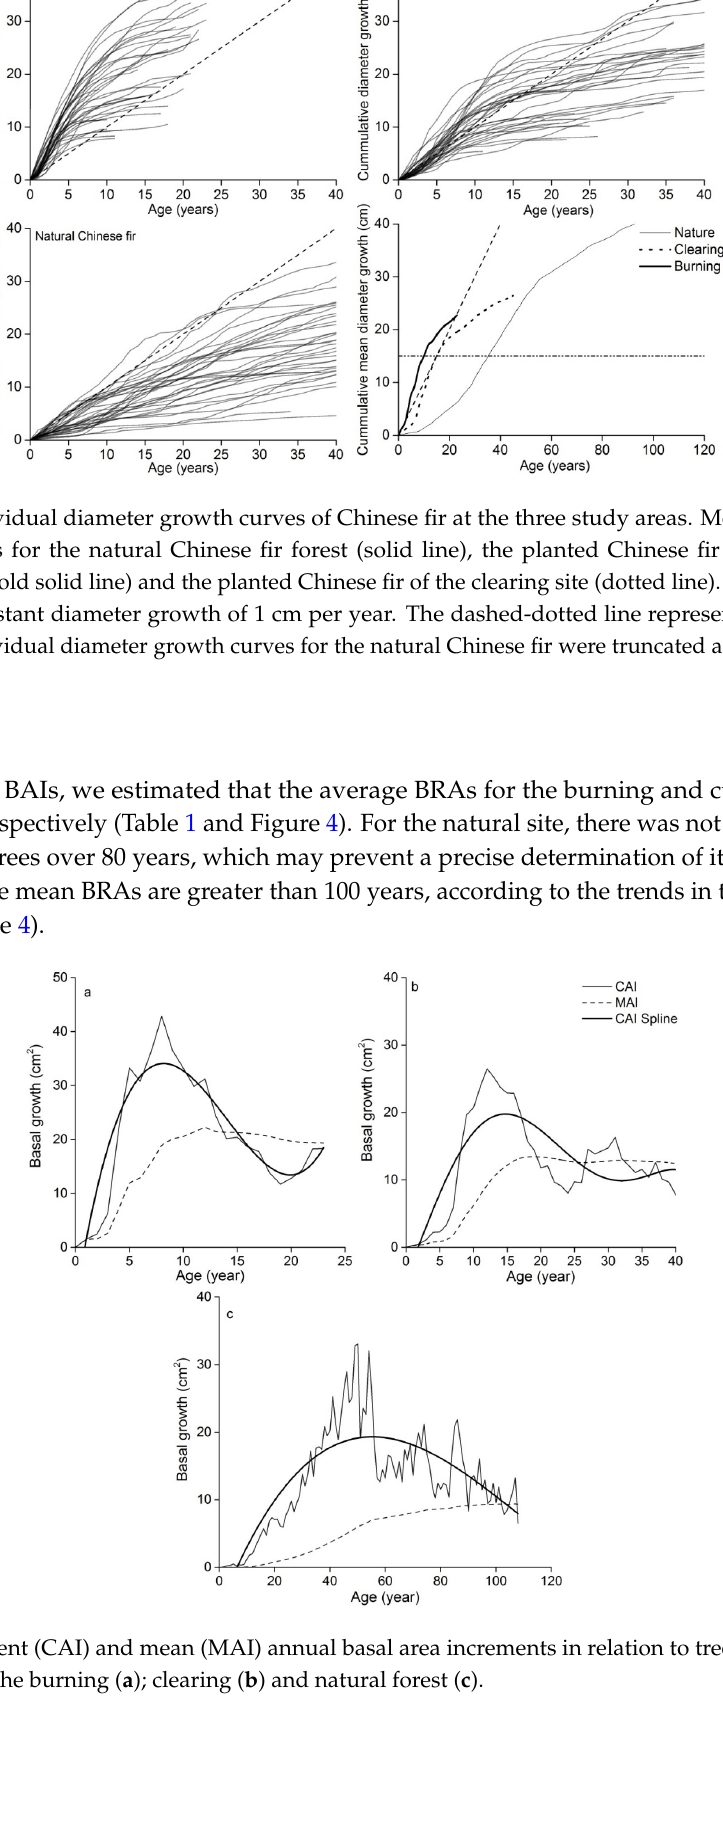
Forests 2016 , 7 , 177 7 of 15 Figure 2. Trees ha − 1 (only for Chinese fir) of each diameter class for the burning and clearing preparation sites. The smooth curves are Gaussian fits to the data. The diameter growth varied considerably between study sites. The individual diameter growth curves showed that the change in growth was very clear among the three study sites (Figure 3). The